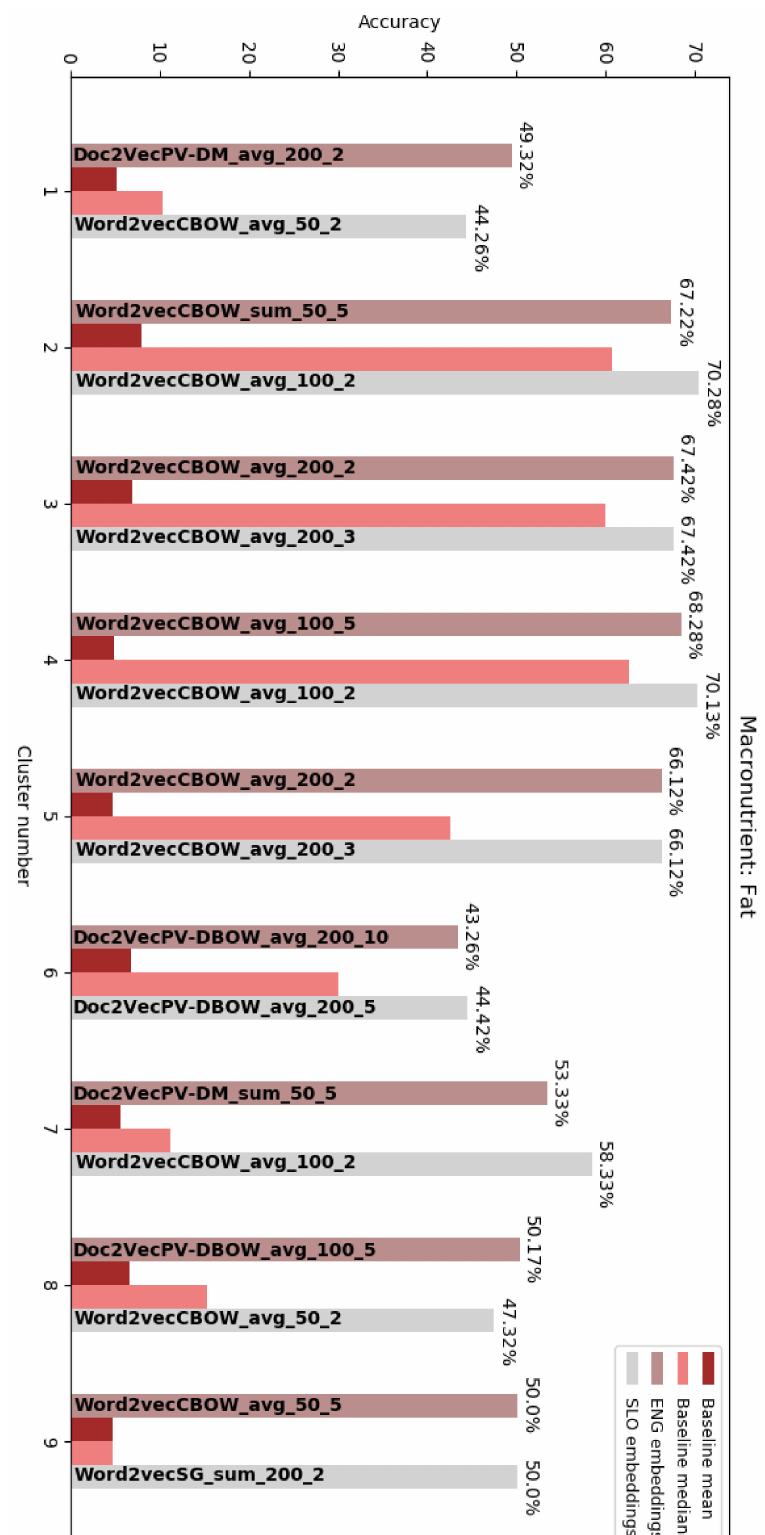
Figure 3. Best prediction accuracies for fat predictions obtained from the embeddings for the English names and Slovene names for each cluster compared to the baseline mean and median for the particular